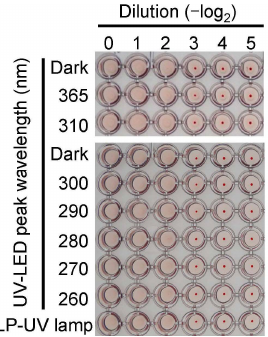
Figure 3. Effect of UV-LED irradiation on the hemagglutination titer. Viral suspensions of the H1N1 subtype (strain A / Puerto Rico / 8 / 1934) were irradiated by UV-LEDs and the LP-UV lamp at 4.8 mJ / cm 2 , and the hemagglutination activity was determined as described in the Materials and Methods